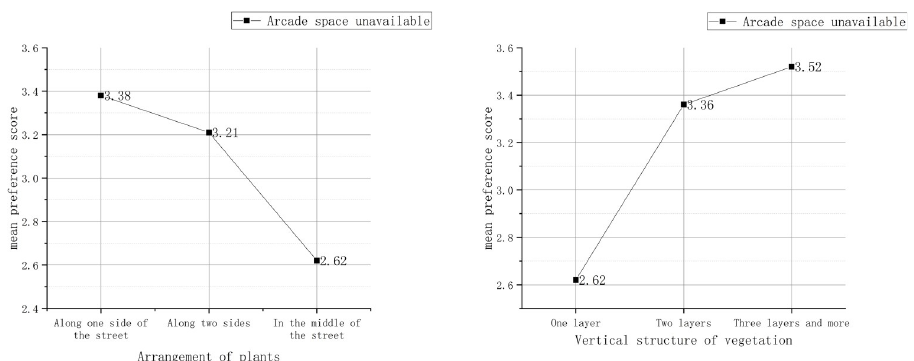
Fig 3. Arrangement of plants and vertical structure of plants.